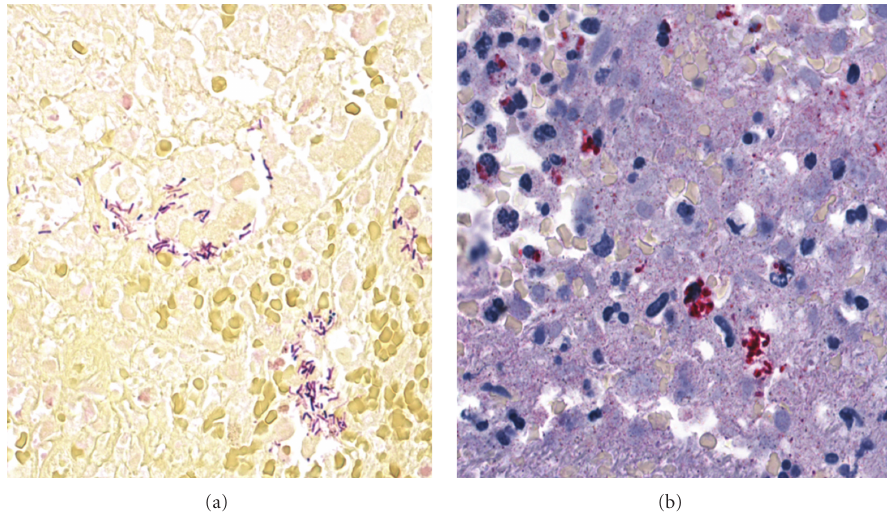
Figure 3: (a) Abundant-gram-positive bacilli in the necrotic endometrial tissues (Gram’s stain). (b) Clostridial antigens (red staining) inside the inflammatory cells present in the necrotic endometrial tissues (IHC using polyclonal anti-clostridium species antibody).